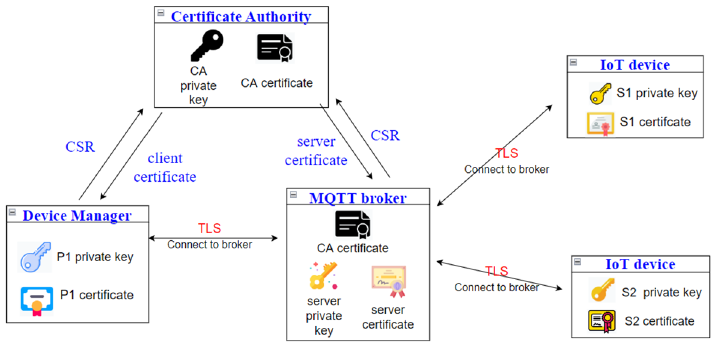
Figure 3. Entities in the new OTA